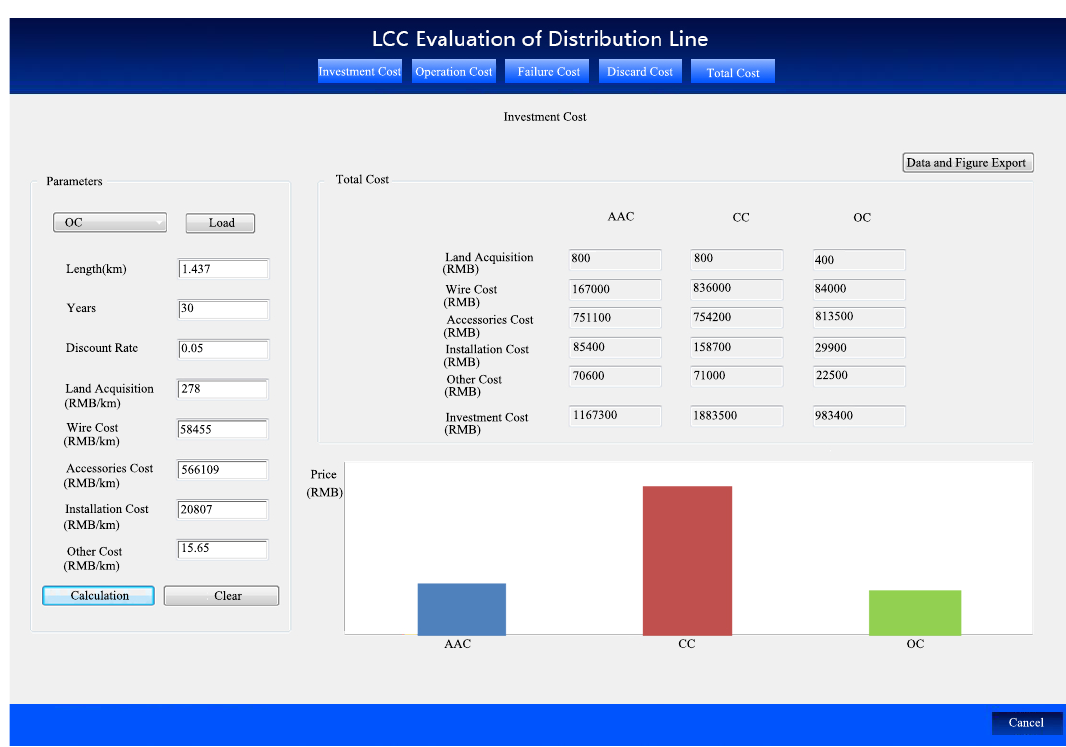
Figure 6. Calculation interface of the software. AAC, aluminum alloy cable; CC, copper cable; OC, overhead